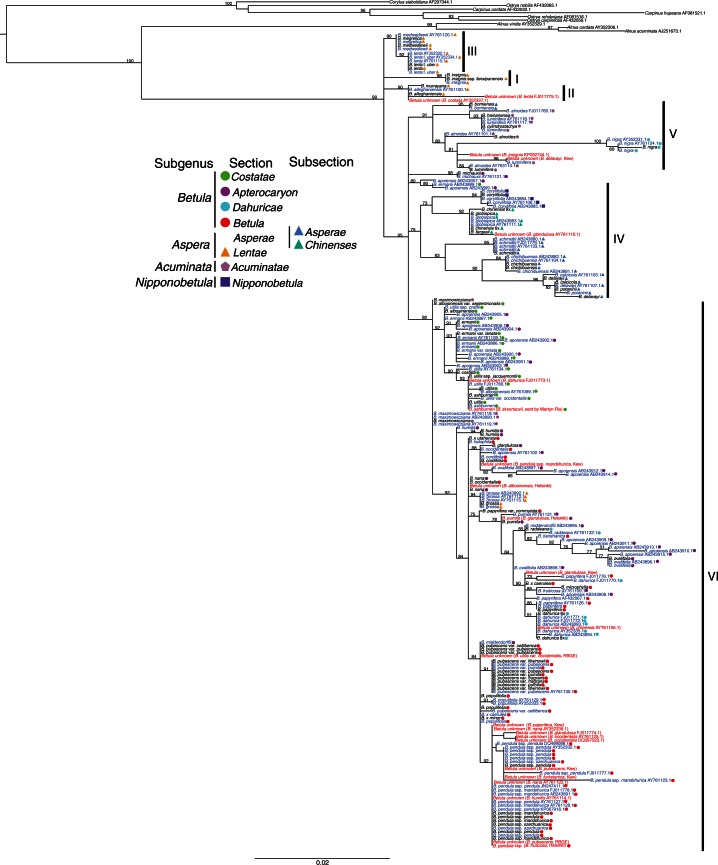
Phylogenetic tree from the maximum likelihood analysis of all Betula L. samples using ITS sequences. Species were classified according to Ashburner and McAllister (2013). Values above branches are bootstrap percentages of ≥50 %. Names marked in red, blue and black represent potentially misidentified accessions, potentially correctly identified accessions and ‘verified’ accessions, respectively. Included in parentheses are the original labels of potentially misidentified species and their sources; the suggested correct identification of these species is placed before the parentheses.